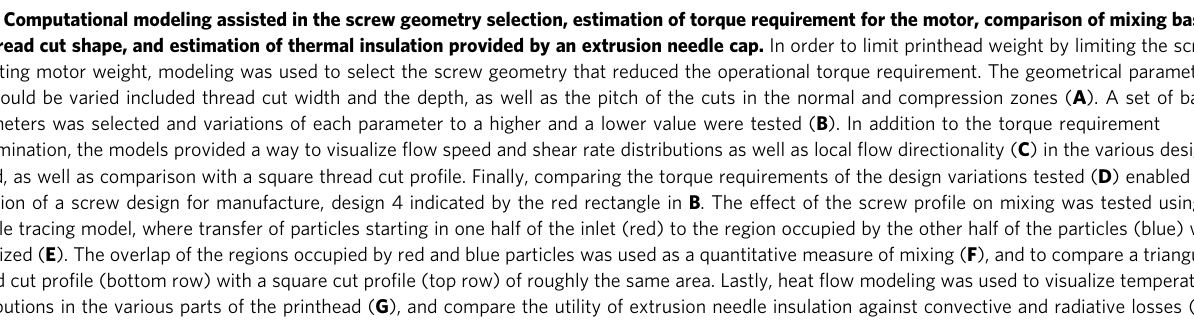
Fig. 2 Computational modeling assisted in the screw geometry selection, estimation of torque requirement for the motor, comparison of mixing based on thread cut shape, and estimation of thermal insulation provided by an extrusion needle cap. In order to limit printhead weight by limiting the screw operating motor weight, modeling was used to select the screw geometry that reduced the operational torque requirement. The geometrical parameters that could be varied included thread cut width and the depth, as well as the pitch of the cuts in the normal and compression zones ( A ). A set of base parameters was selected and variations of each parameter to a higher and a lower value were tested ( B ). In addition to the torque requirement determination, the models provided a way to visualize fl ow speed and shear rate distributions as well as local fl ow directionality ( C ) in the various designs tested, as well as comparison with a square thread cut pro fi le. Finally, comparing the torque requirements of the design variations tested ( D ) enabled the selection of a screw design for manufacture, design 4 indicated by the red rectangle in B . The effect of the screw pro fi le on mixing was tested using a particle tracing model, where transfer of particles starting in one half of the inlet (red) to the region occupied by the other half of the particles (blue) was visualized ( E ). The overlap of the regions occupied by red and blue particles was used as a quantitative measure of mixing ( F ), and to compare a triangular thread cut pro fi le (bottom row) with a square cut pro fi le (top row) of roughly the same area. Lastly, heat fl ow modeling was used to visualize temperature distributions in the various parts of the printhead ( G ), and compare the utility of extrusion needle insulation against convective and radiative losses (